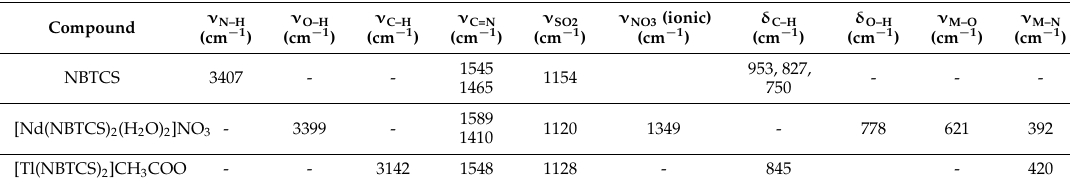
Table 3. Infrared spectral data for NBTCS and its complexes.